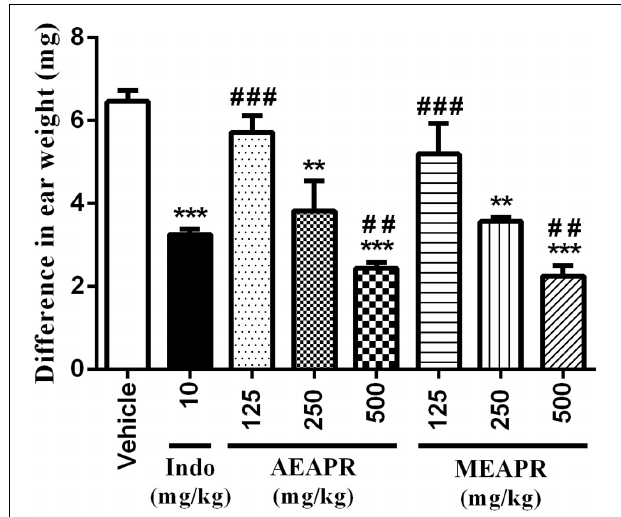
FIGURE 1 | Effect of AEAPR and MEAPR administrated orally on xylene-induced mouse ear edema test. Animals (six mice each group) were treated orally with distilled water (vehicle), indomethacin (10 mg/kg: Indo), MEAPR or AEAPR (125, 250, and 500 mg/kg), prior to topical application of xylene (0.02 ml) on the right ear of the mice. Values are mean ± SEM of weight difference (in mg) between the right and the left ear sections of the same animal. ∗∗ p < 0.01 and ∗∗∗ p < 0.001 compared to vehicle-treated group; ## p < 0.01 and ### p < 0.001 compared to CFA + indomethacin- treated group, using Kruskal–Wallis ANOVA test.